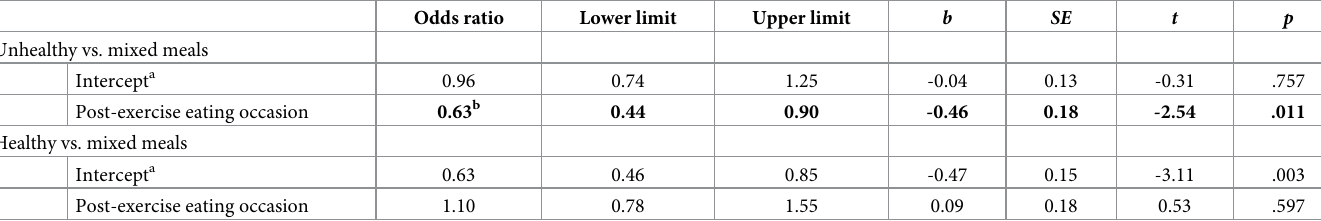
Table 1. Exercise as a predictor of meal healthiness (Study 1). Odds ratio Lower limit Upper limit b SE t